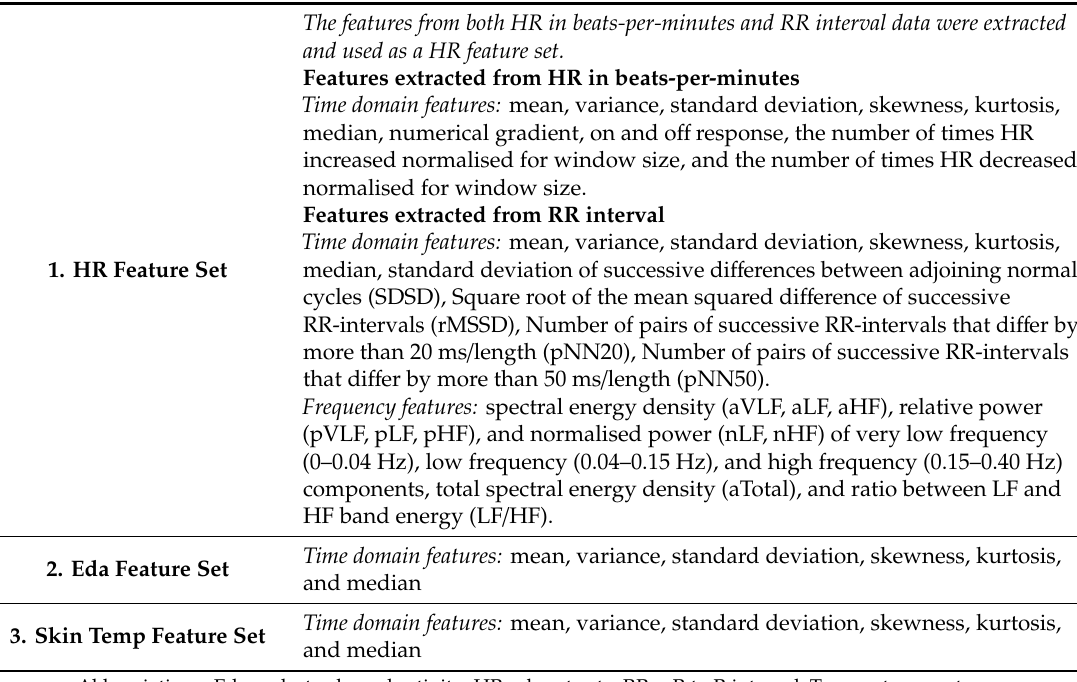
Table 1. Feature set extracted from each sensor